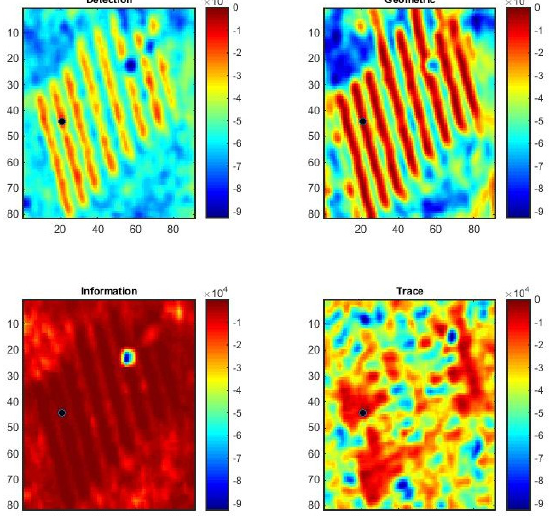
Figure 3. Target similarity images of selected pattern (the target pixel is marked by the black dot in the target similarity images)